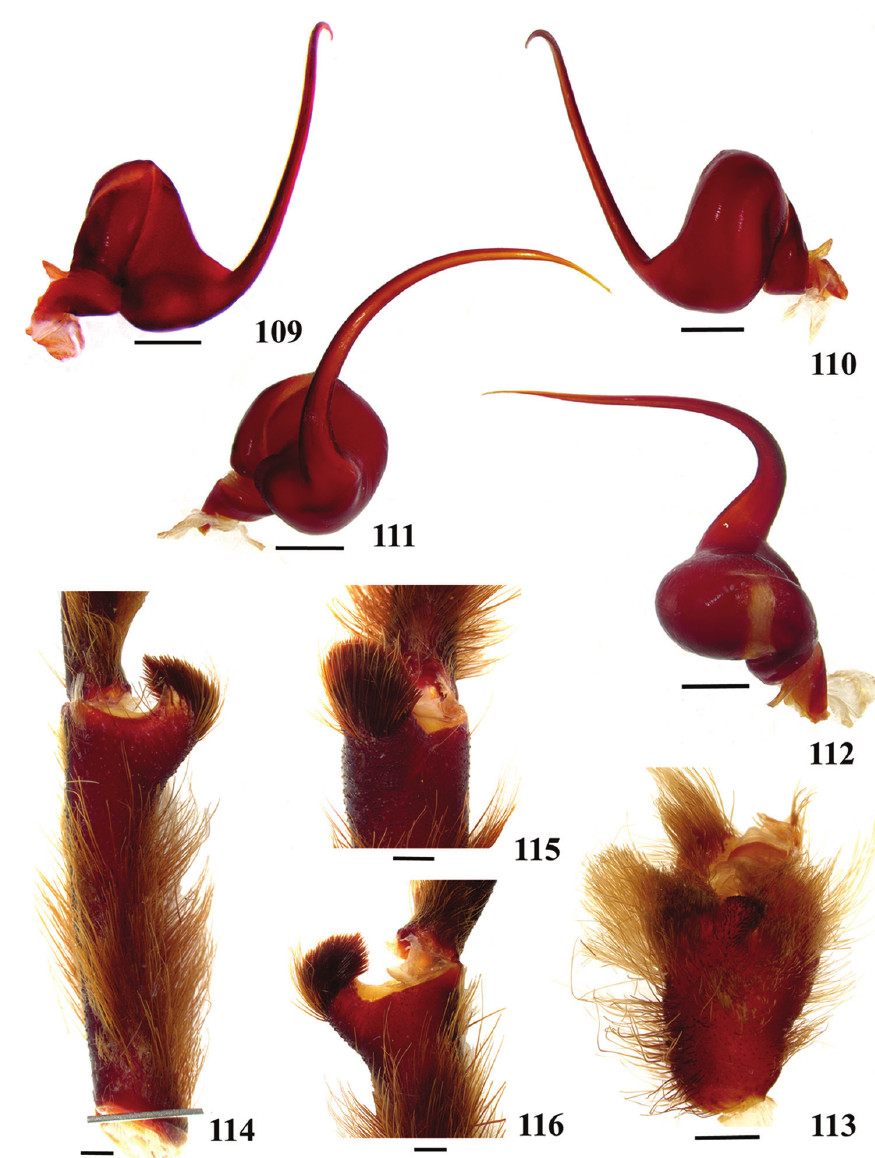
Figures 109–116. Avicularia juruensis Mello-Leitão, 1923, male lectotype (MZUSP 125B). 109–112 left palpal bulb 109 prolateral 110 retrolateral 111 frontal 112 dorsal 113 left cymbium, dorsal 114–116 right tibial apophysis of leg I (mirrored) 114 prolateral 115 ventral 116 retrolateral. Scale bars = 1 mm. tural La Paya [0°28'N, 75°49'W], Mamansoyá (Mamangaya [ sic ]), 1 male, 21